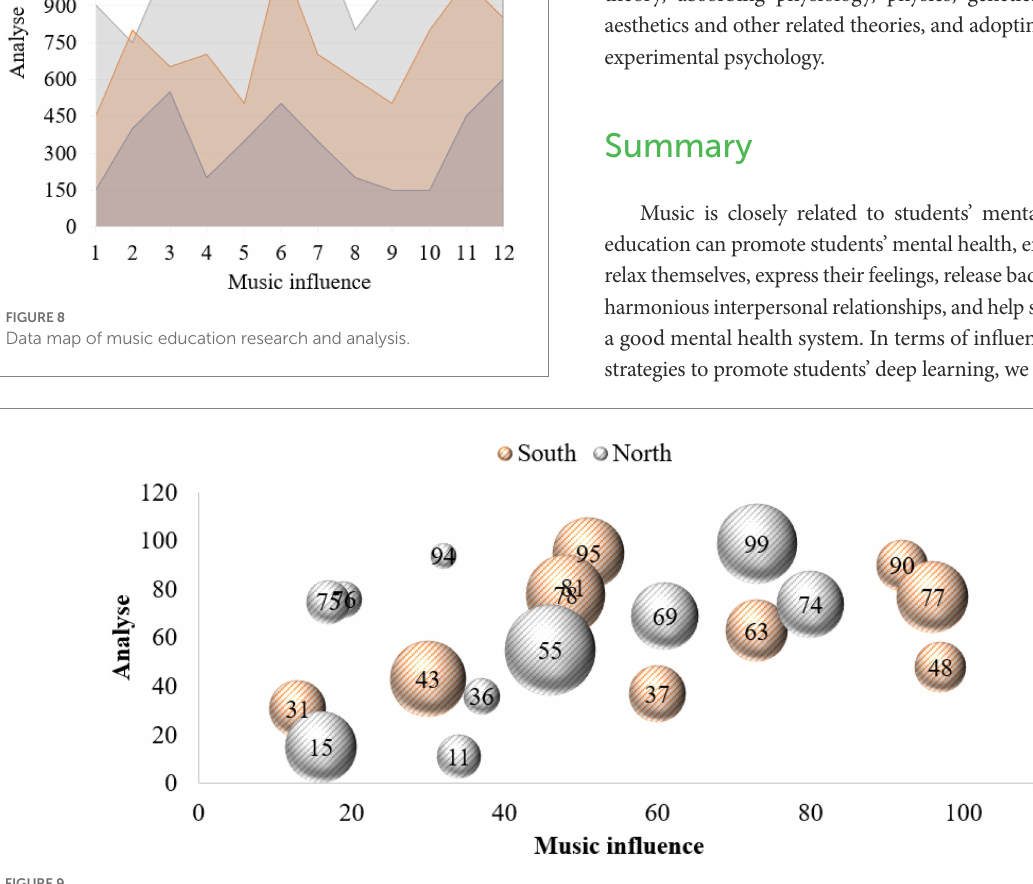
FIGURE 9 Data map of music education impact